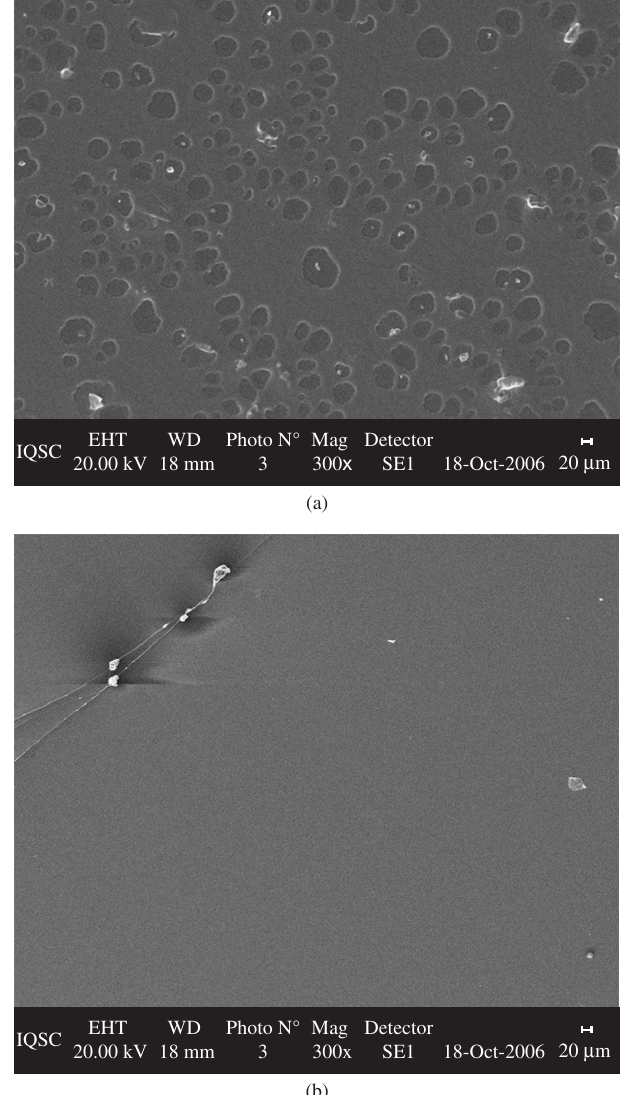
Figure 4. GC/TFSF micrographies before and a) and after b) the extraction of the surfactant.